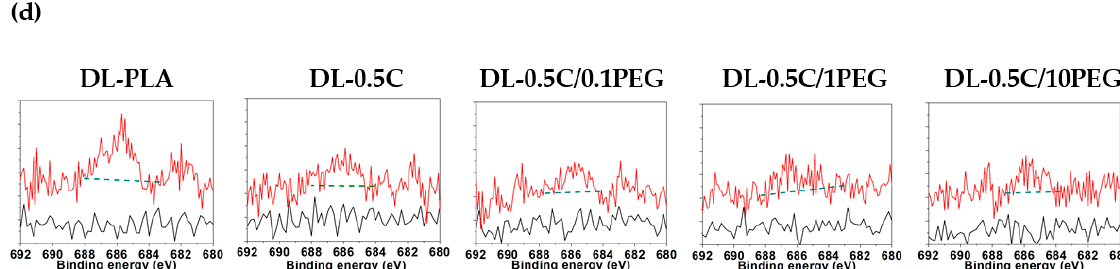
Figure 6. FT-IR and XPS analysis of DEX-loaded nanofibers. ( a ) The FT-IR spectra of PLA nanofibers 0.5 C nanofibers, DEX, and PEG. These spectra showed that only DEX demonstrates peaks between 1600 and 1700 cm − 1 . ( b ) The FT-IR spectra of nanofiber before (red) and after (black) DEX loading. The green dotted line indicated the adsorption region between 1600 and 1700 cm − 1 . ( c ) The XPS spectra were applied to investigate elements of nanofibers. ( d ) The F 1s peaks of nanofibers before (black) and after (red) DEX loading were investigated. Green dashed lines were baselines for the calculation of the area of F 1s peaks. Table 6. Area ratios of F 1s/C 1s.